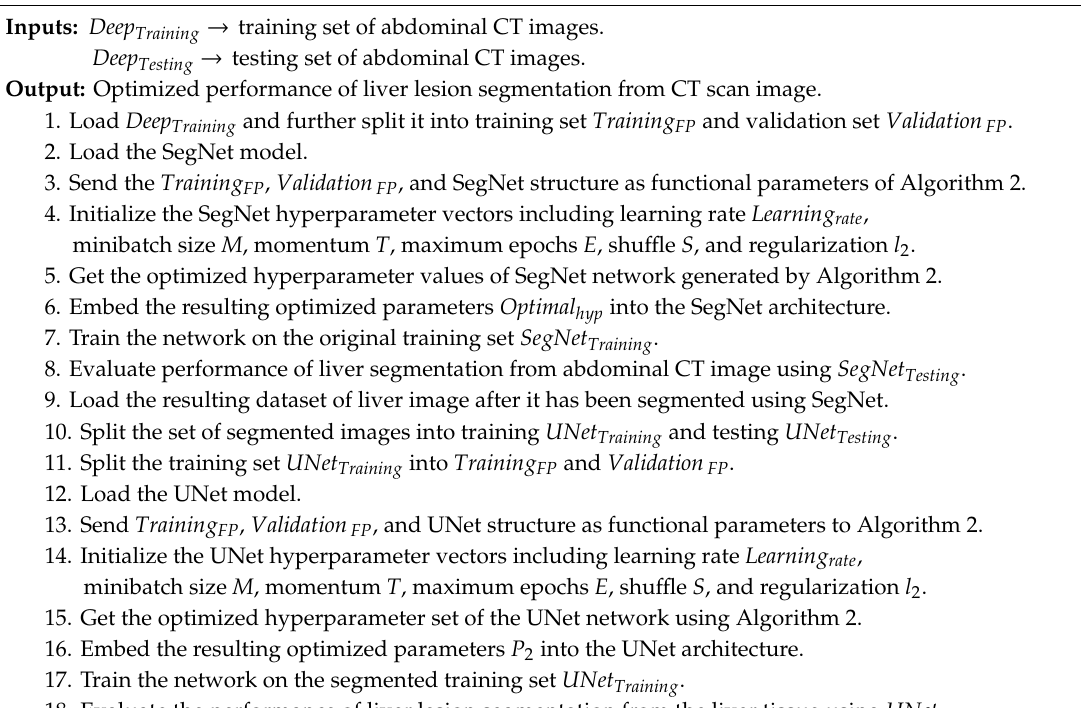
Algorithm 1: The proposed hybrid SegNet-UNet-ABC for liver lesion segmentation. Inputs: Deep Training → training set of abdominal CT images.